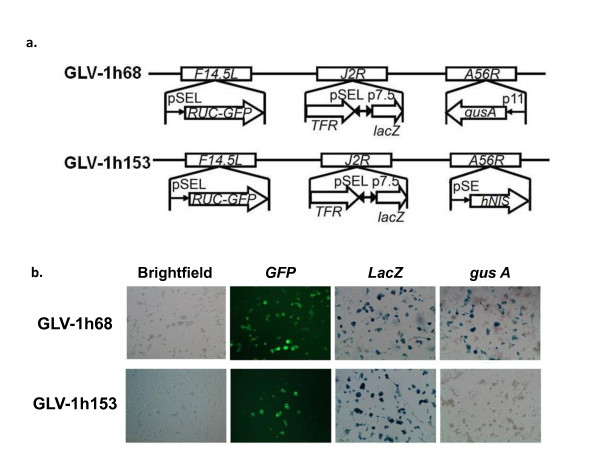
GLV-1h153 construct. a. GLV-1h153 was derived from GLV-1h68 by replacing the gus A expression cassette at the A56R locus with the hNIS expression cassette through in vivo homologous recombination. Both viruses contain RUC-GFP and lacZ expression cassettes at the F14.5L and J2R loci, respectively. PE, PE/L, P11, and P7.5 are VACV synthetic early, synthetic early/late, 11K, and 7.5K promoters, respectively. TFR is human transferrin receptor inserted in the reverse orientation with respect to the promoter PE/L.b. Confirmation of GFP, LacZ, and lack of gus A marker gene expression in GLV-1h153 infected CV-1 cells. While the gus A gene cassette is expressed in cells infected with parent virus GLV-1h68, this has been replaced by the hNIS gene cassette in GLV-1h153, leading to loss of gus A expression.